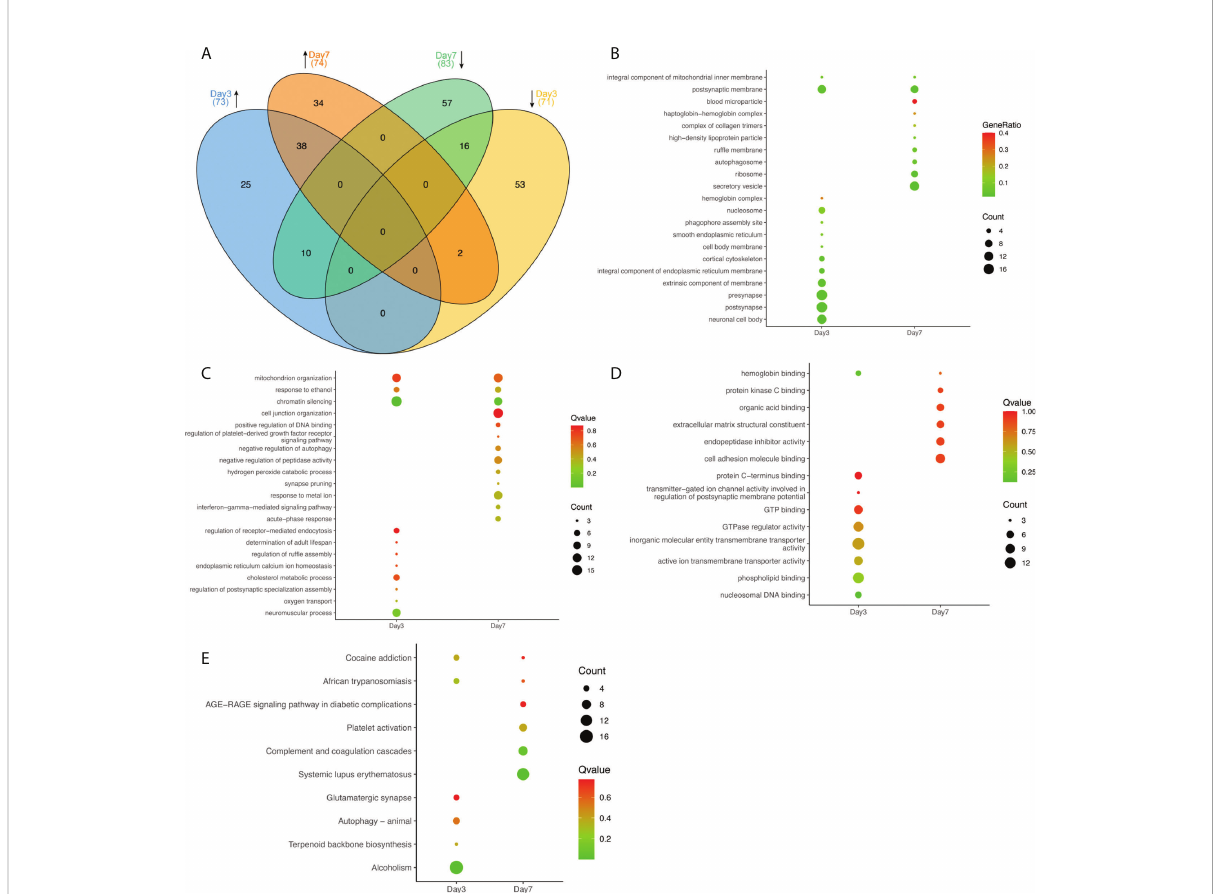
FIGURE 2 The expression of representative proteins in the infected brains at Day 3 and Day 7. (A) Venn diagram illustrating the relationships of proteins at various timepoints. Upward pointing arrows indicate upregulation, whilst downward pointing arrows illustrate downregulation. Numbers in brackets represent the number of proteins in each subset. (B – D) Some representative results of GO function enrichment amongst differentially expressed proteins, (B) affected cellular components, (C) biological process, and (D) molecular function. The size of individual circles corresponds to the number of enriched proteins. Red indicates the highest, blue the lowest P value. (E) Partial results of KEGG pathways enrichment in DEPs. The size of circles represents the number of proteins in a group. Red indicates the highest Q value, green indicates the lowest Q